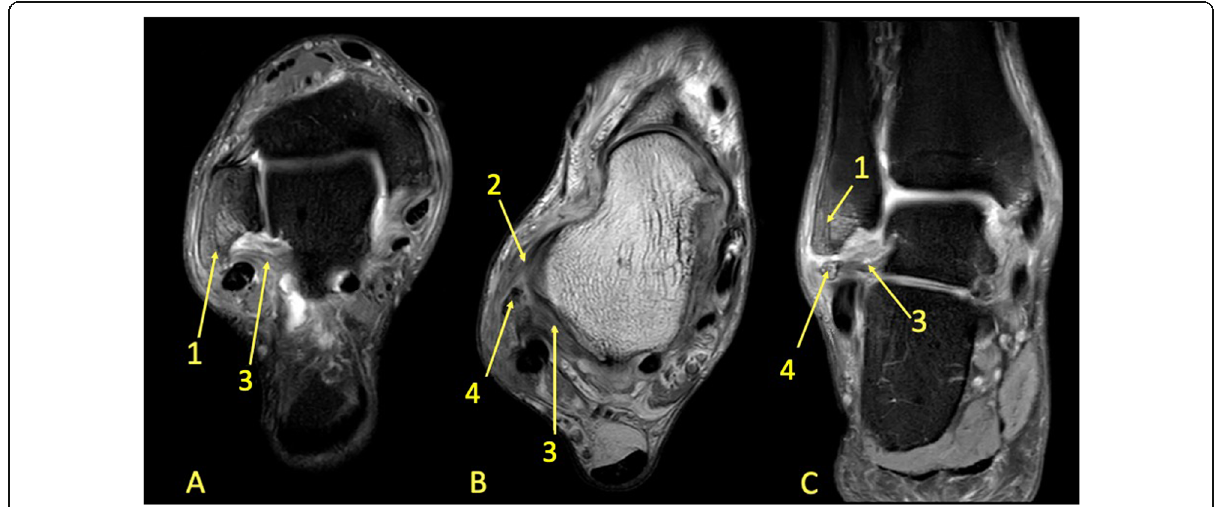
Fig. 6 A 24-year-old male imaged on suspicion of an anterior tibiofibular ligament rupture 2 weeks after an ankle injury. MRI showed an avulsion of the anterior talofibular ligament. (1) BME in the lateral malleolus, (2) the anterior talofibular ligament, (3) the posterior talofibular ligament, and (4) an avulsed bone fragment from the lateral